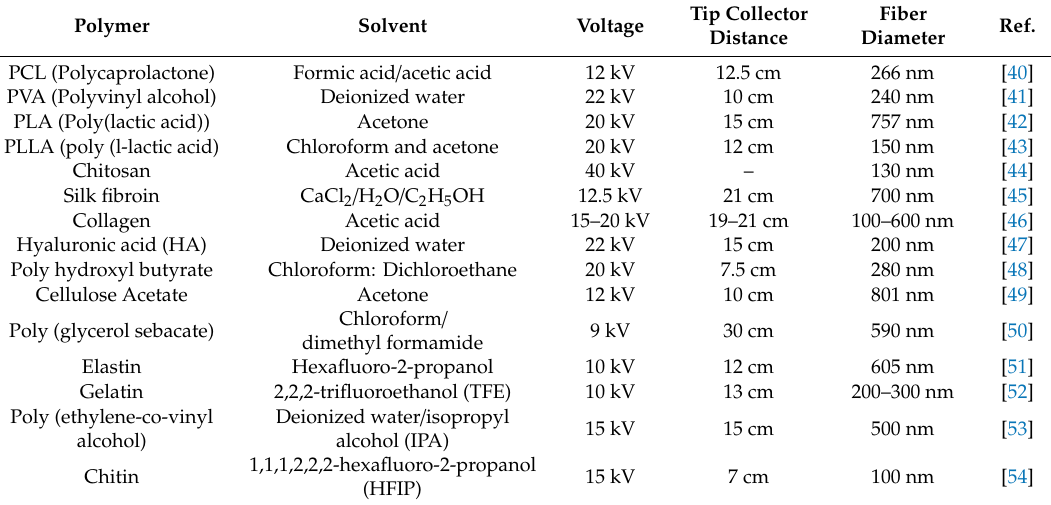
Table 1. Parameters of electro-spinning of di ff erent